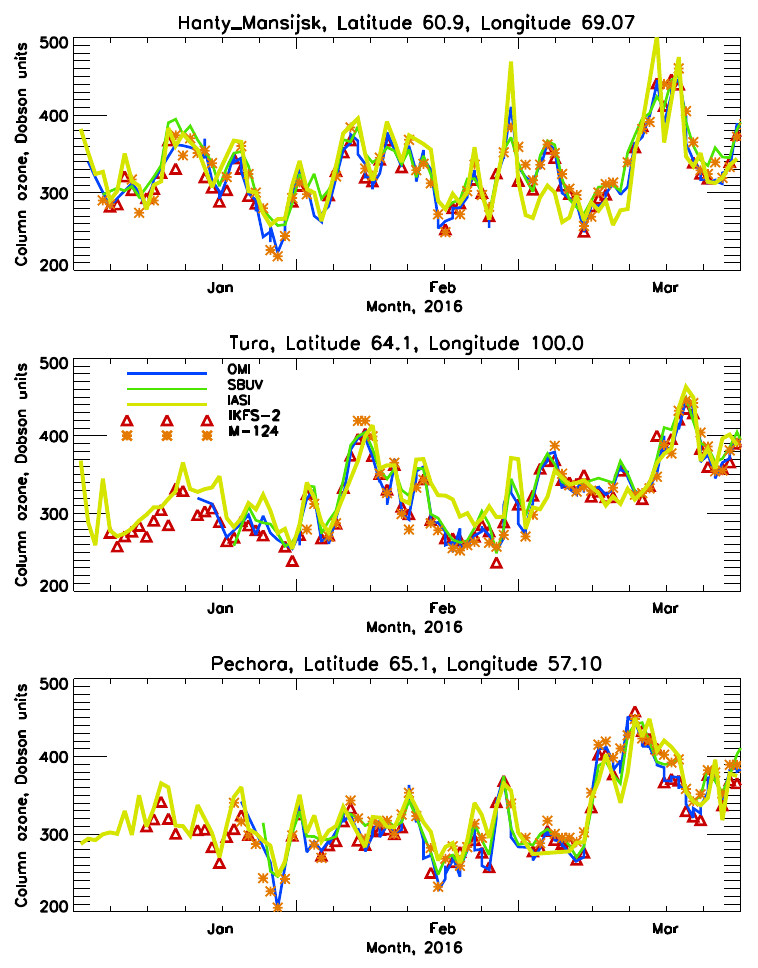
Figure 2. Total ozone measurements provided by OMI, M-124, IKFS-2, IASI, and SBUV for the stations Khanty-Mansiysk, Tura, and